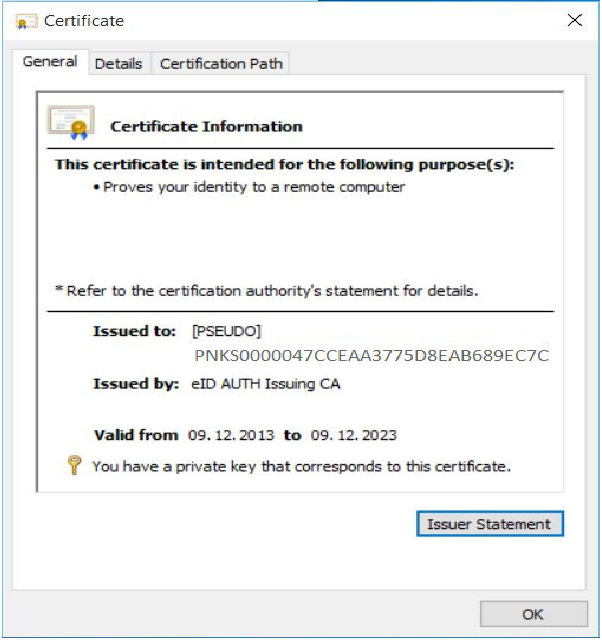
Fig. 2. X.509 [PSEUDO]